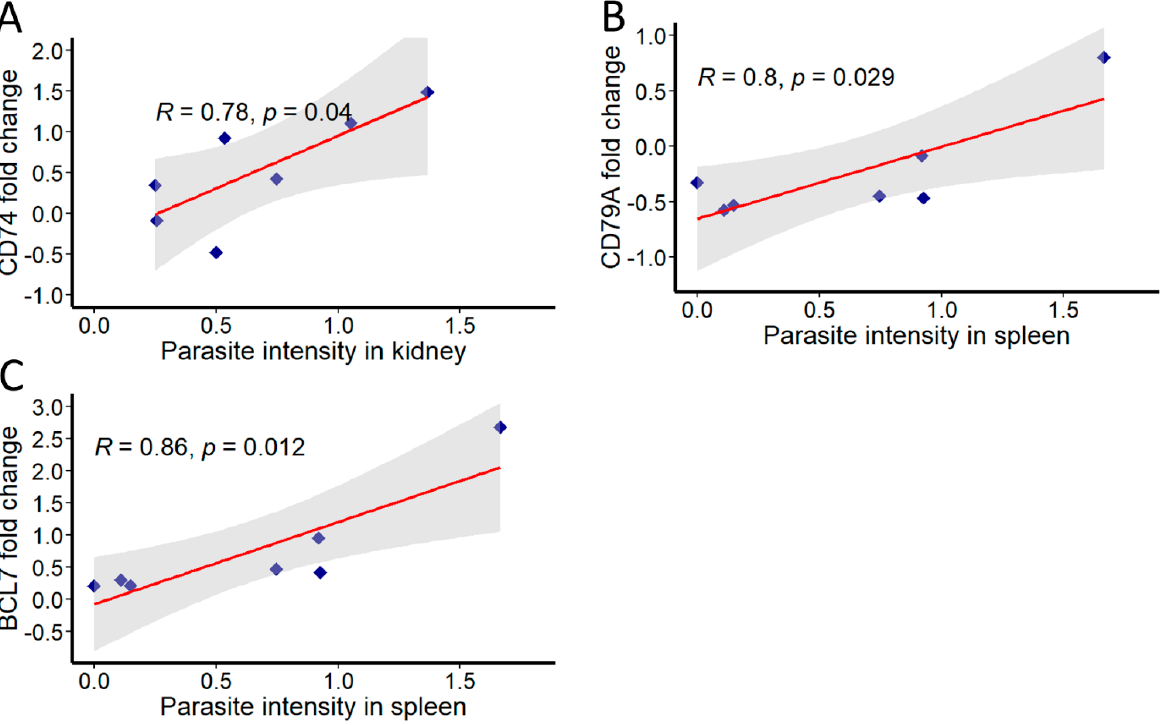
Figure 6. Correlation of T. bryosalmonae intensity and immune genes in infected brown trout kidney and spleen. The mean values of fold change and parasite intensity in infected brown trout ( n = 6) were log2 transformed and correlation coefficient (R) was determined using Pearson product-moment at each time point. Pearson product-moment correlation was calculated and statistical significance was tested at p = 0.05. Shaded region represents 95% confidence intervals. ( A ) CD74, ( B ) CD79A and ( C ) BCL7.